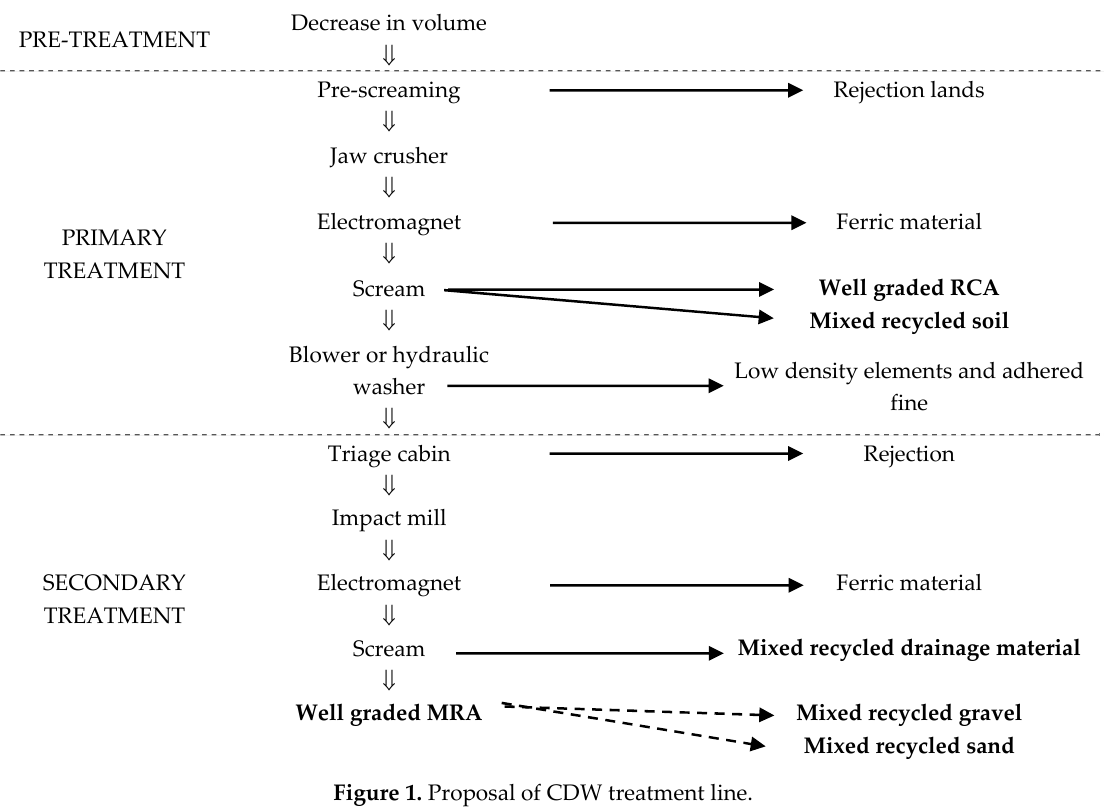
Figure 1. Proposal of CDW treatment